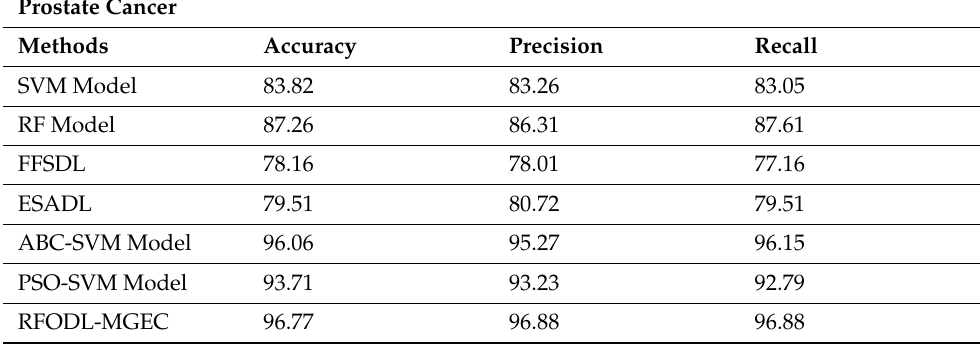
Table 5. Comparative analysis of RFODL-MGEC technique with recent algorithms for prostate cer dataset. cancer